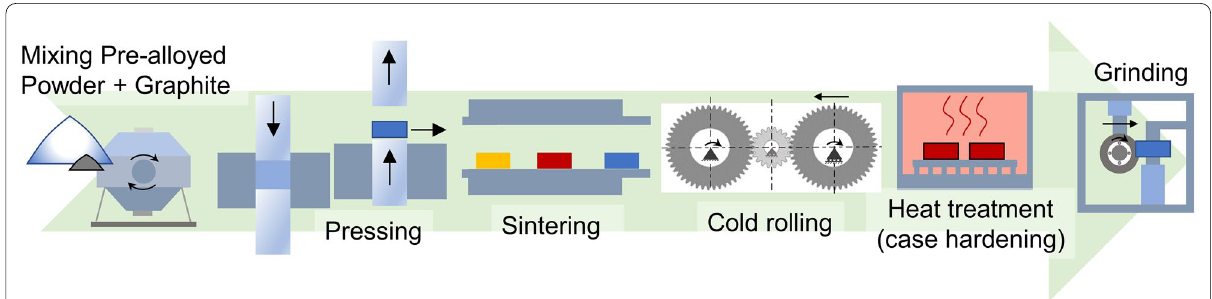
Figure 1 Schematic representation of the entire PM process chain of high strength sintered